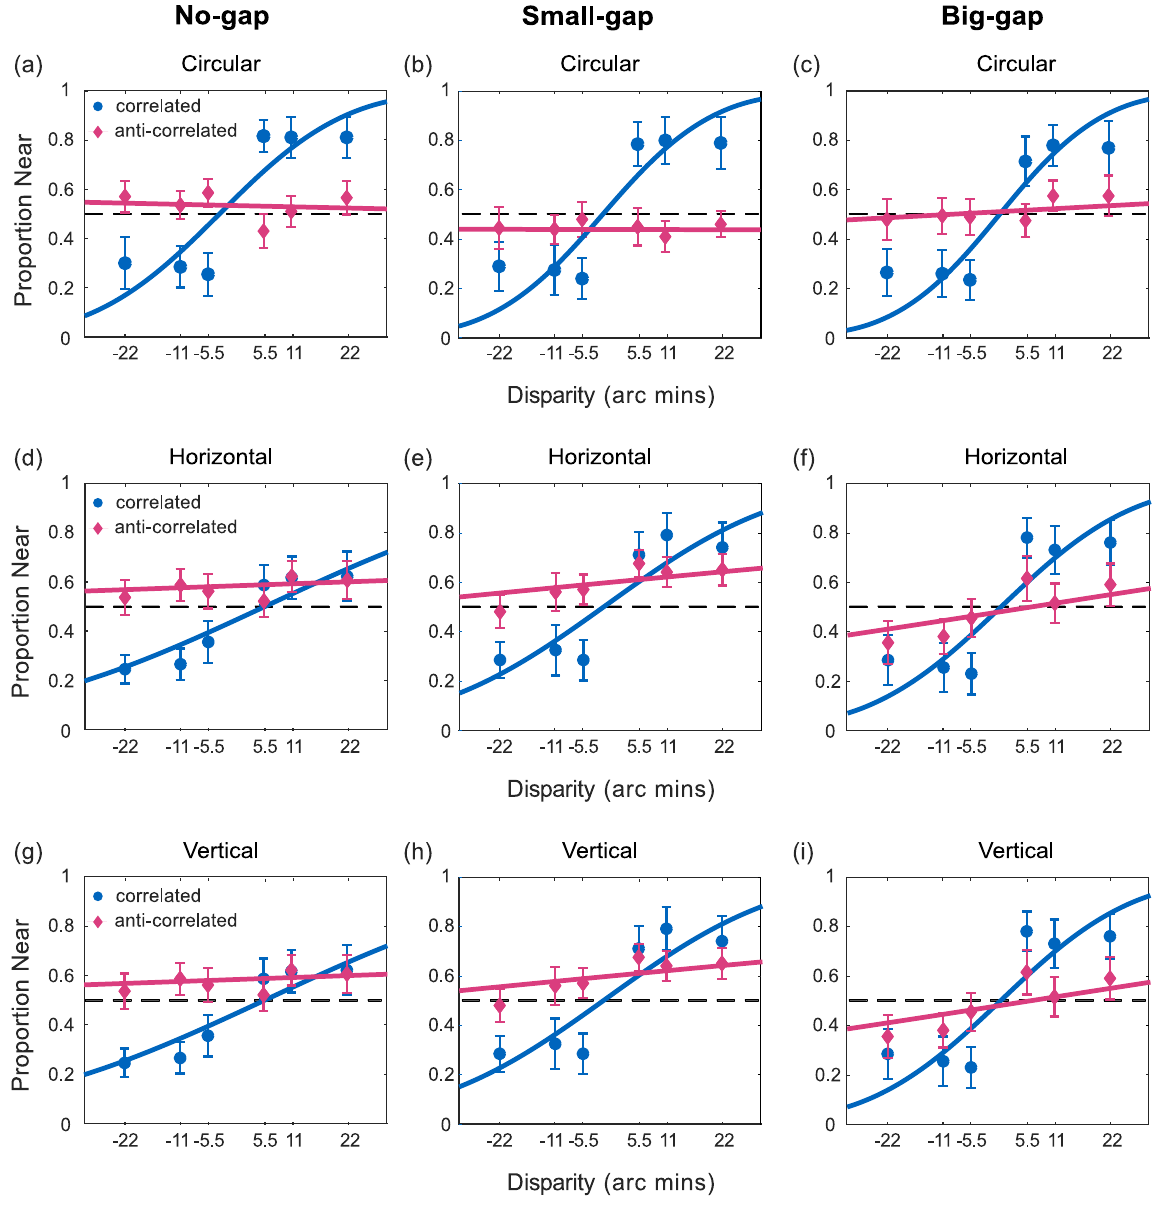
Figure 7. Mean proportion of near responses as a function of disparity for stimuli with no-gap (left), small-gap (middle) and big-gap (right). Circular results are shown in ( a – c ), Horizontal results in ( d – f ) and Vertical results in ( g – i ). Separate plots chart the responses to anti-correlated (pink) and correlated (blue) stimuli. The dashed line for each plot reflects performance at chance, uncrossed and crossed disparities are shown with negative and positive values. Error bars are ± 1 standard error of the